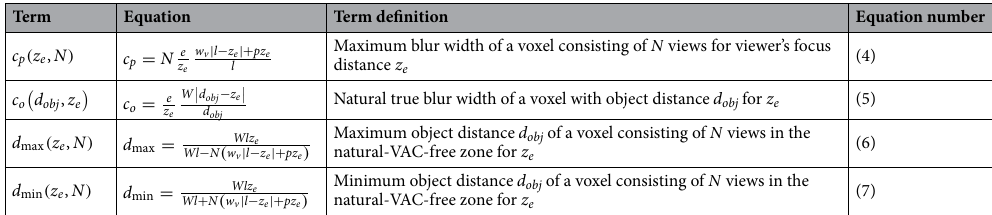
Table 1. Derived equations for distinguishing the natural-VAC-free zone from the pseudo-VAC-free zone in an SMV display.